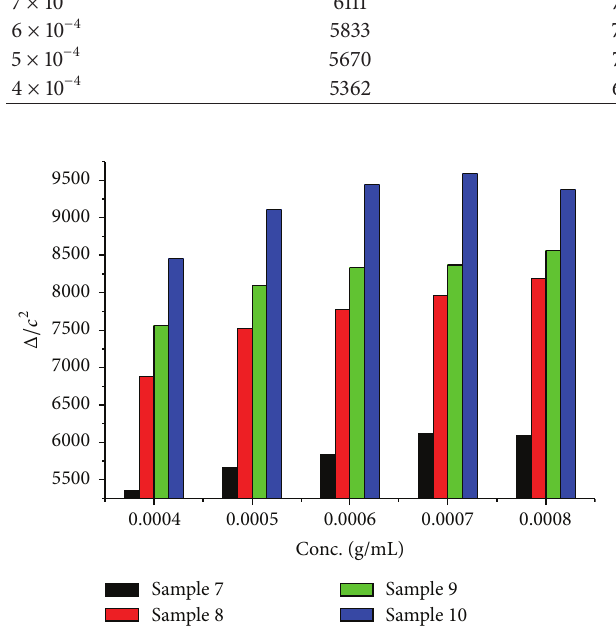
Figure 2: Dependence of Δ / c 2 on the concentration of sample 7–10.